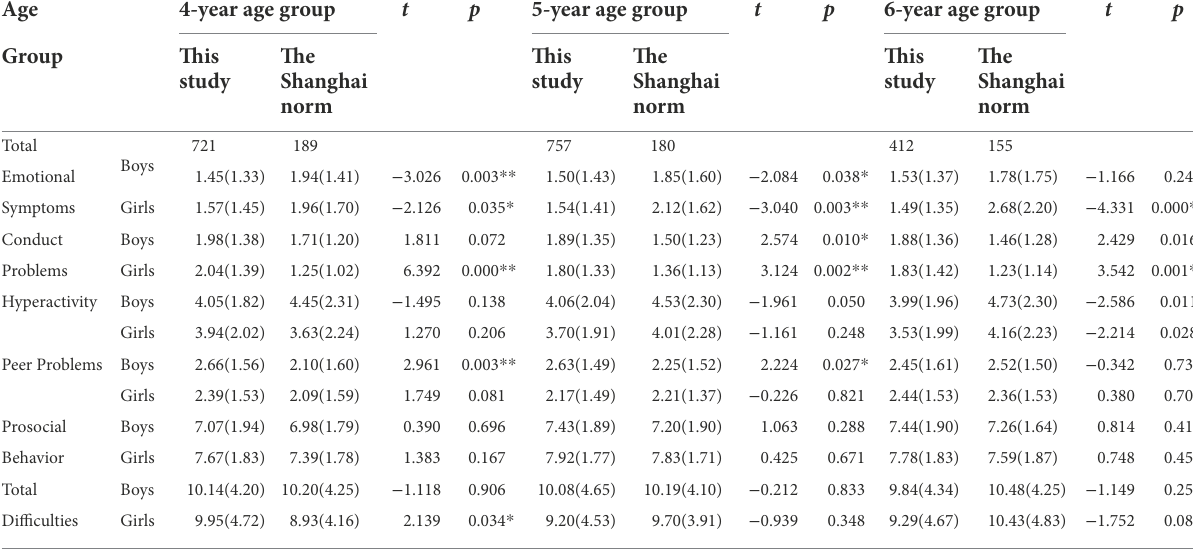
TABLE 3 Comparison of preschool children’s SDQ scores with the Shanghai